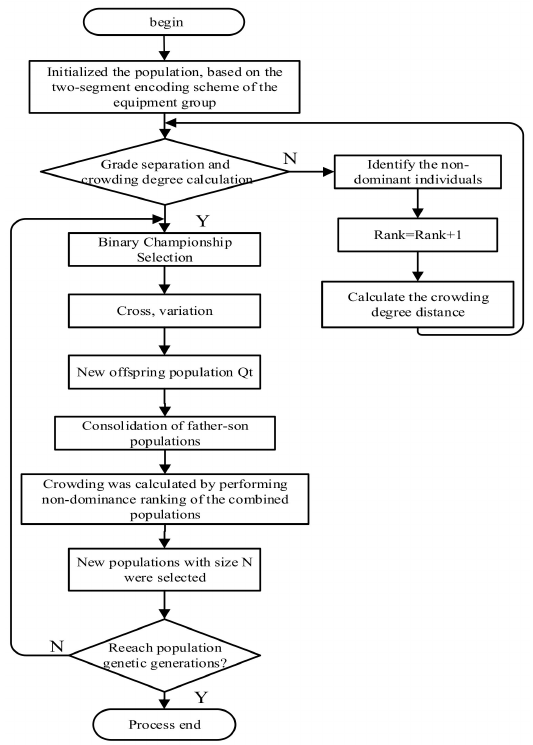
Figure 3. Flow chart for NSGA-II